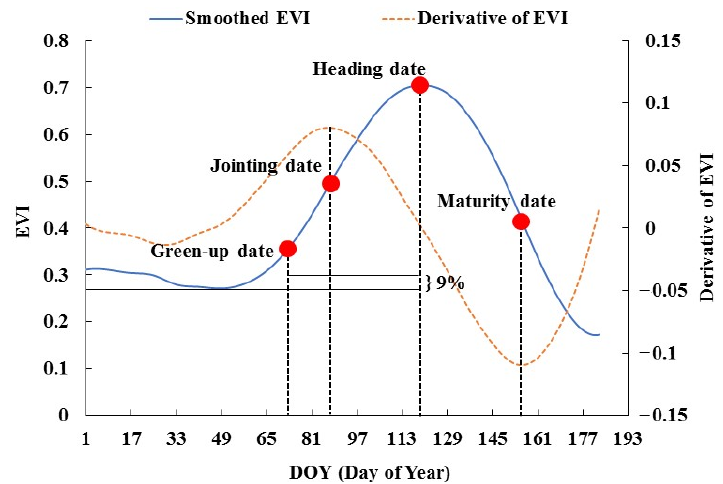
Figure 3. Winter wheat phenological stages extraction.